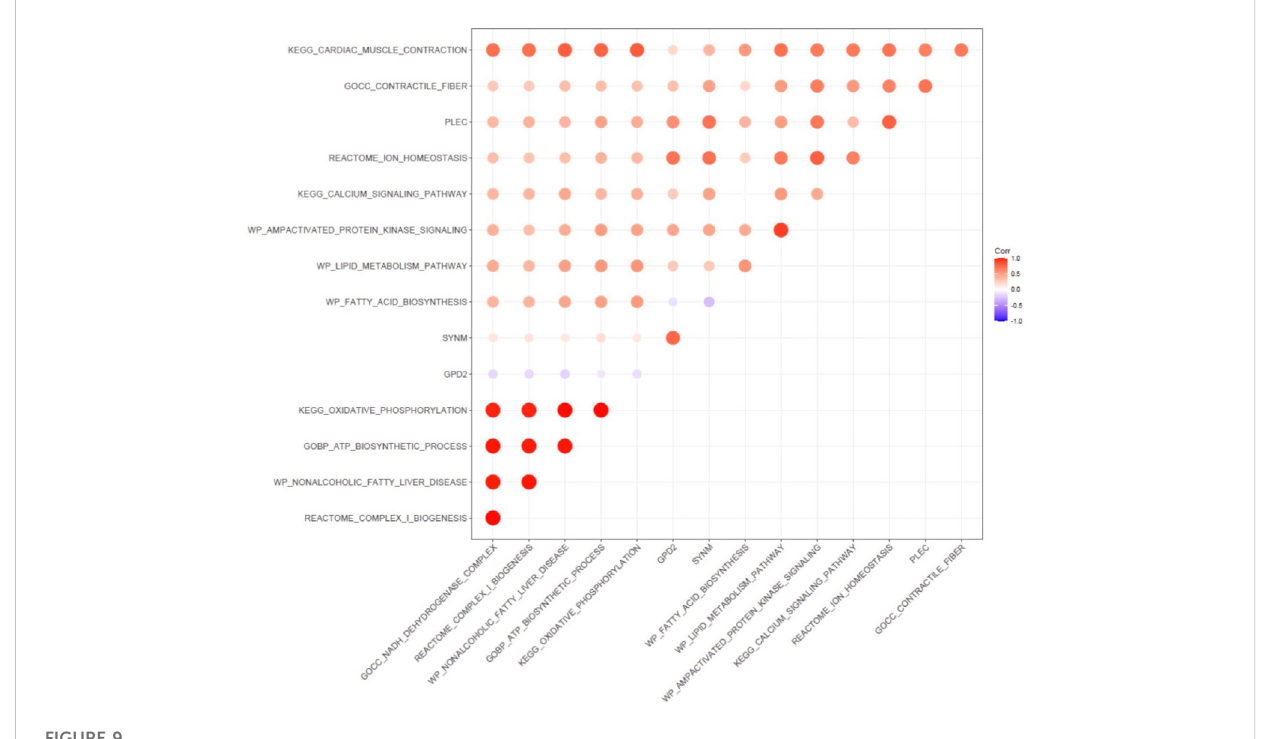
FIGURE 9 Gene set variation analysis (GSVA) for correlation of enriched gene